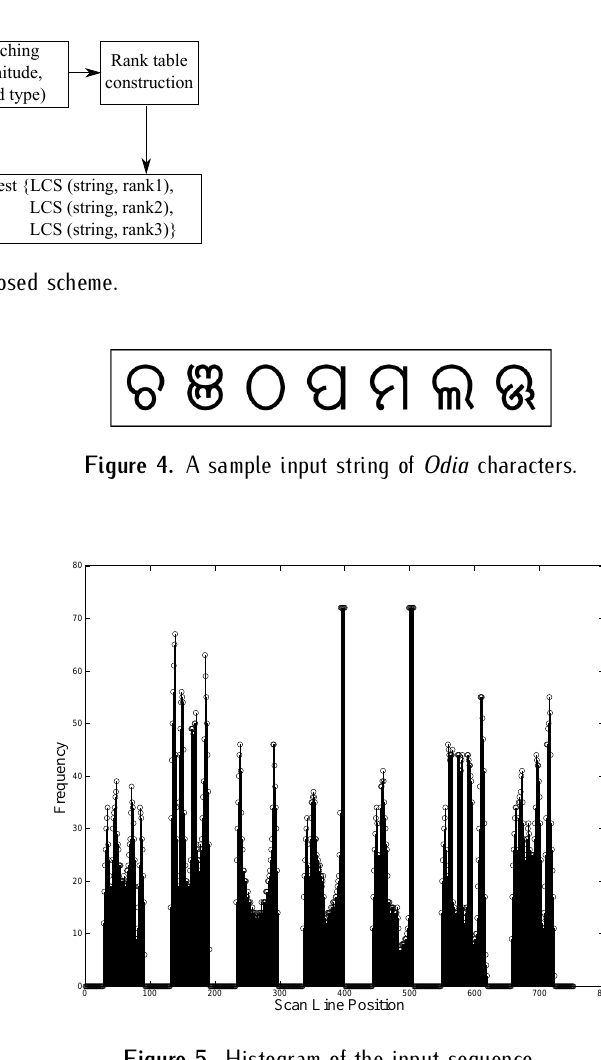
Figure 5. Histogram of the input